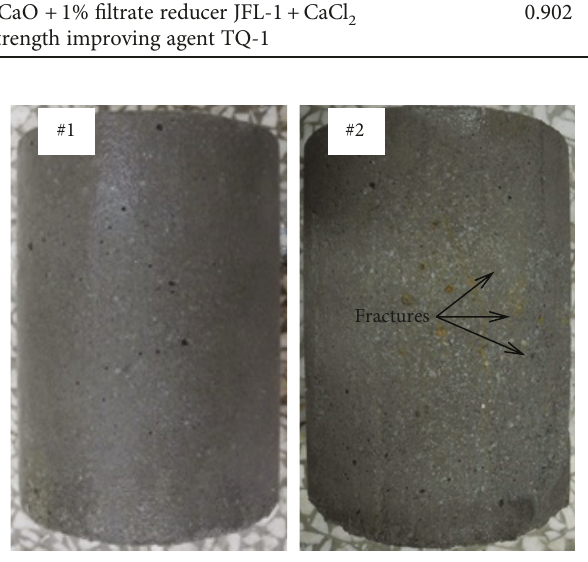
Figure 8: The cores fractured by water (#1) and a bentonite slurry